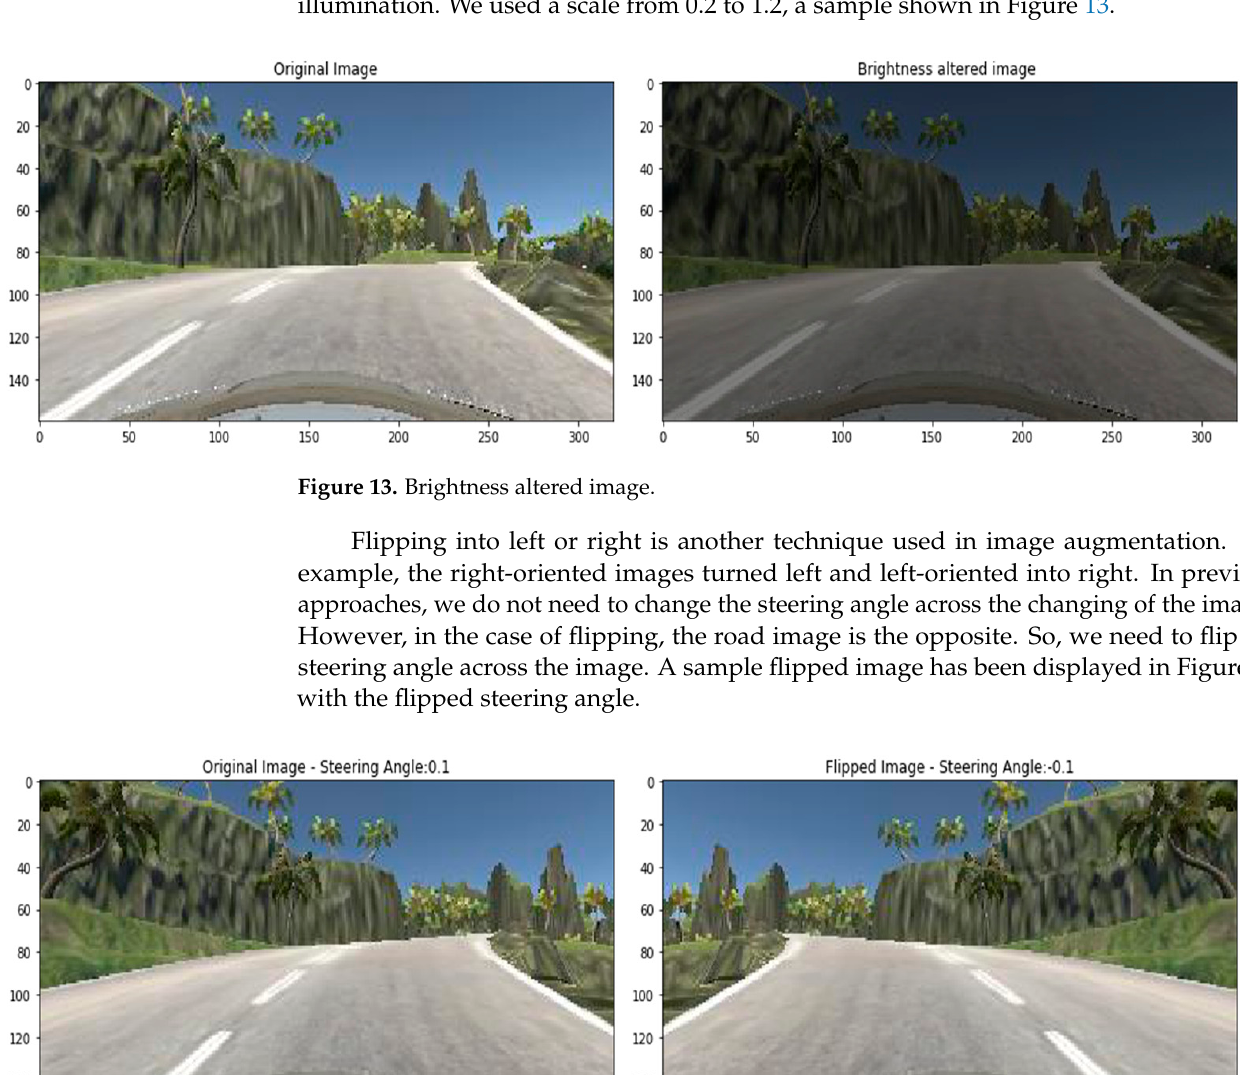
Figure 12. Panned image.